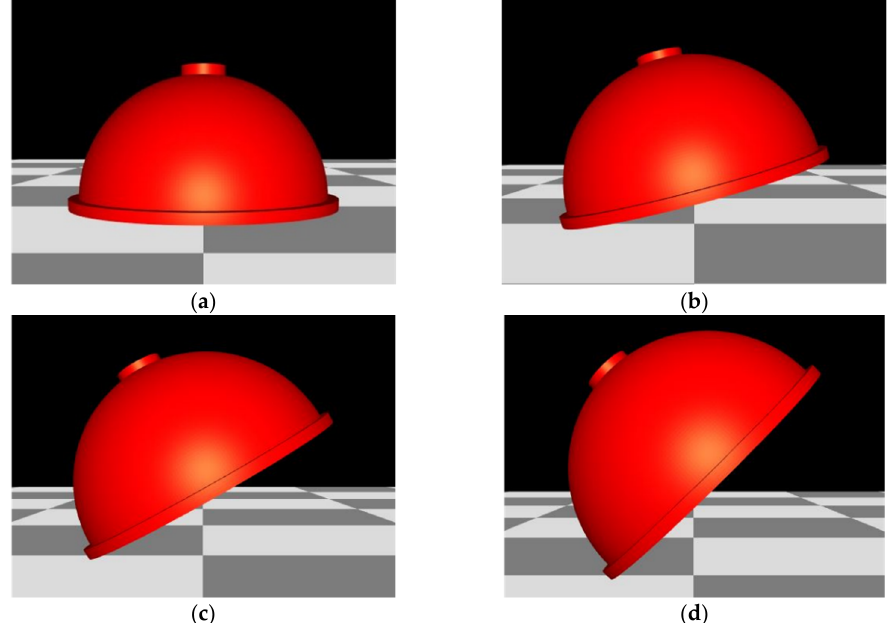
Figure 13. Schematic diagram of different forming angles of the acetabular cup: ( a ) 0 ◦ ; ( b ) 15 ◦ ; ( c ) 30 ◦